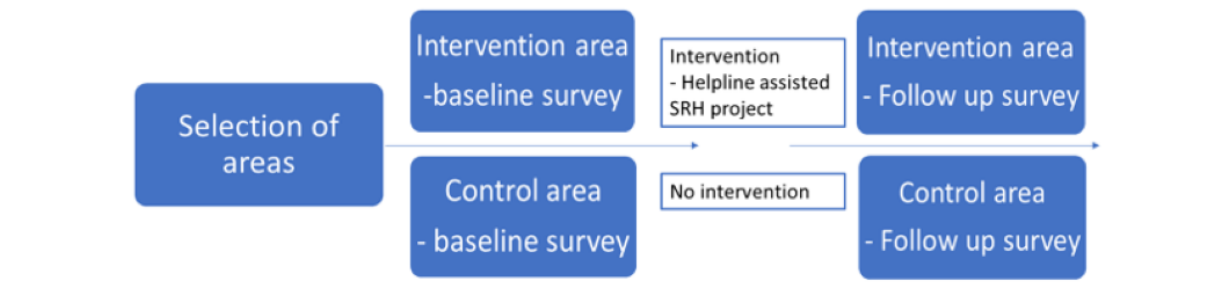
Figure 2. Study design. SRH: sexual and reproductive